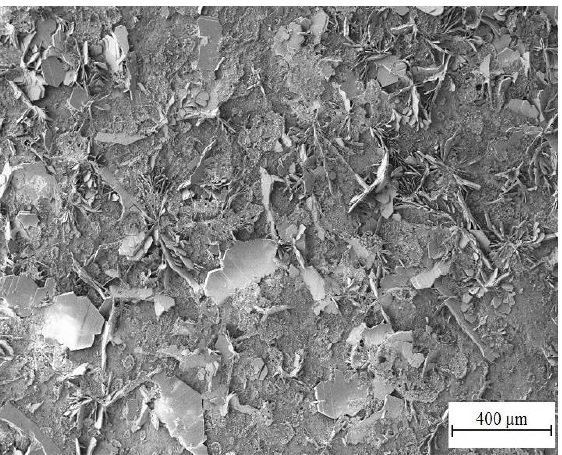
Figure 17. Morphology of precipitated corrosion products on the surface of HDG sample after exposure (3 months) in model concrete pore solution of pH 12.8 with addition of KMnO 4 − (solution Mn (1) ).